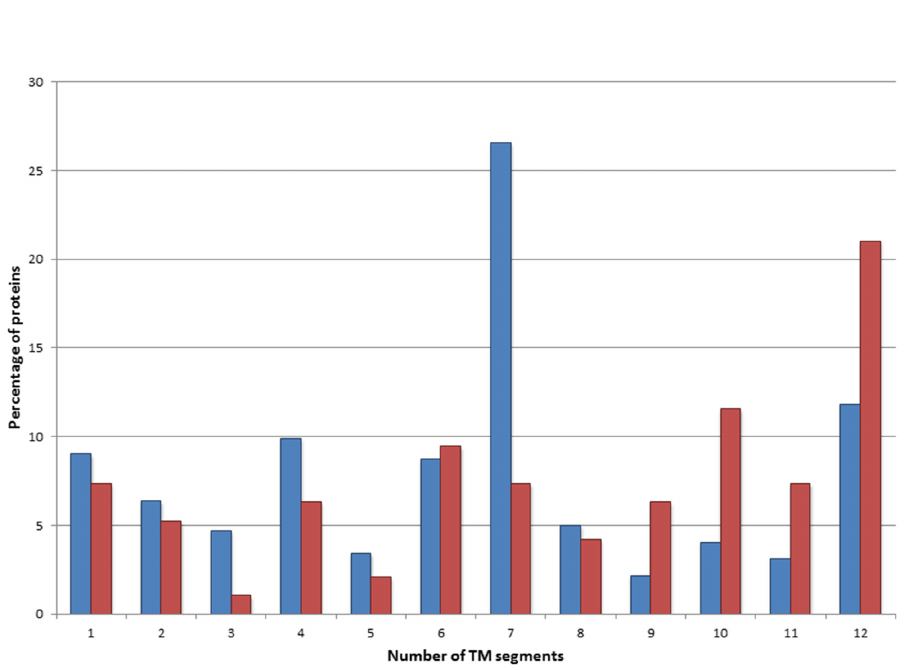
Fig 4. Distribution of TMPs containing naturally occurring arginine amino acids and disease associated glycine to arginine mutations within the TM region. Blue bars represent those proteins which contain arginine residue(s) in the TM segment. Red bars represent those proteins which contain disease- associated glycine to arginine mutation(s) within the TM segment.